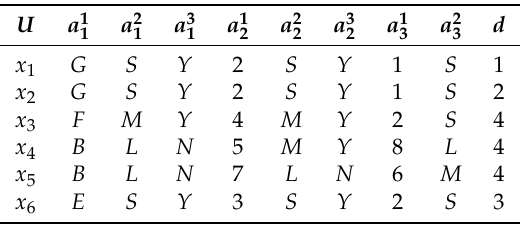
Table 5. A generalized inconsistent multi-scale information